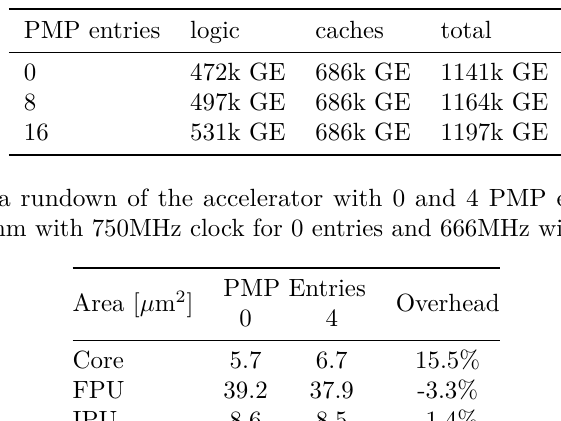
Table 1: Size of the default configuration of the Ariane core in gate equivalents (GE), synthesized in 22nm at 1GHz with varying number of PMP entries.